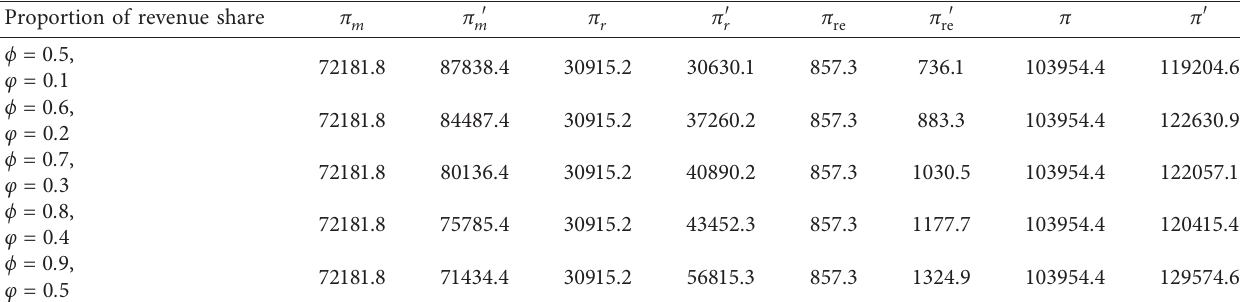
Figure 10: Effect of changes in supplier carbon emission reduction cost coefficient β on emission reduction effort coefficient under different decision-making conditions. Table 1: Changes in profits after